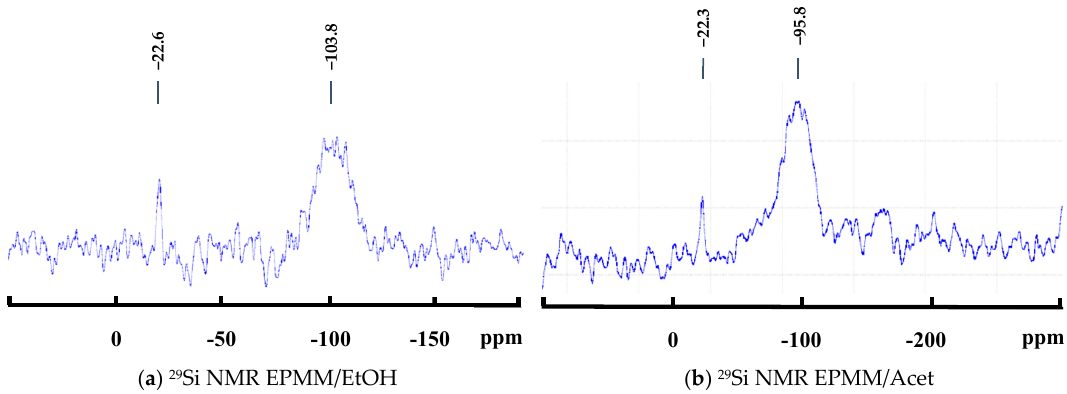
Figure 6. 29 Si NMR spectra of the synthesized emulsion polymerized mixed matrix (EPMM) membranes: ( a ) EPMM/EtOH membrane and ( b ) EPMM/Acet membrane.